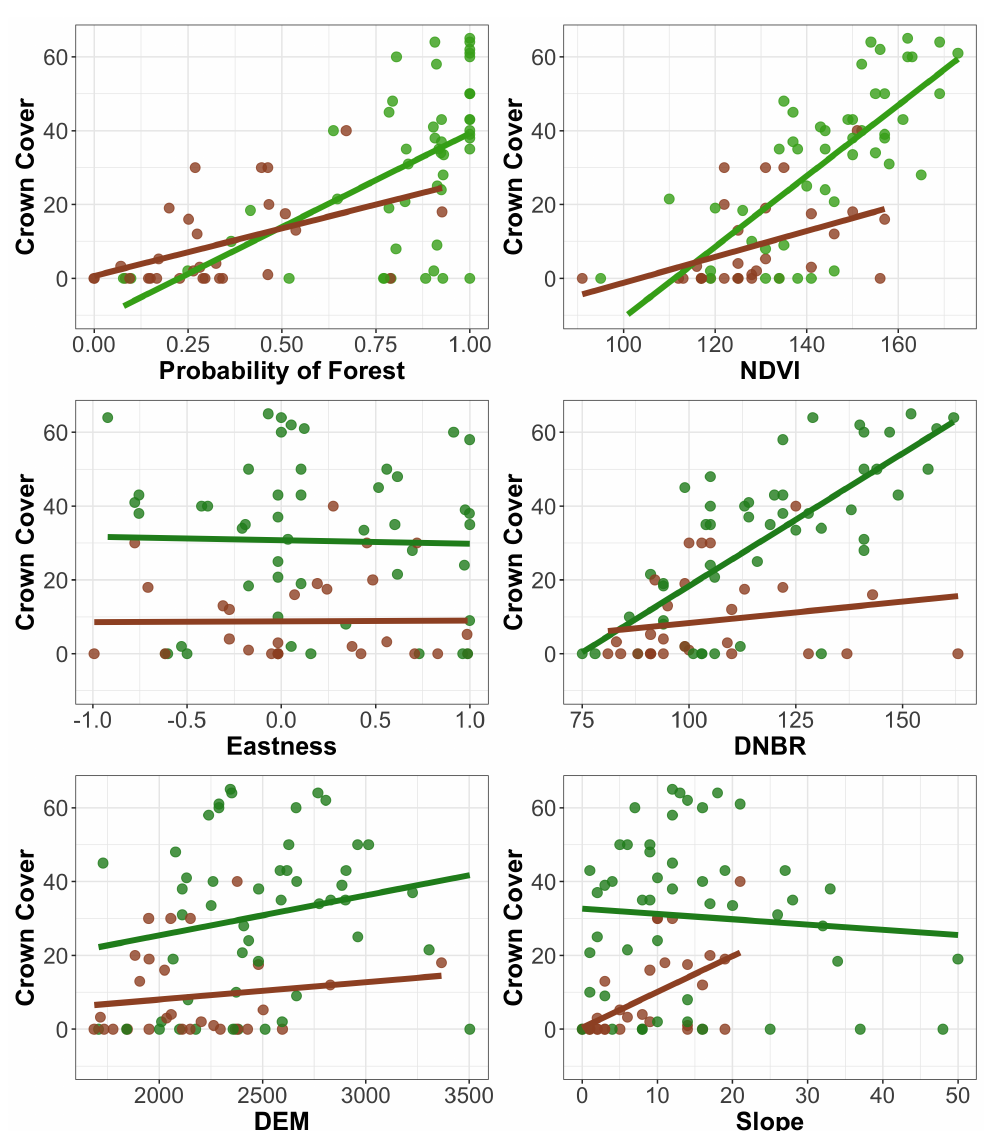
Figure 3. Crown cover graphed against the quantitative auxiliary variables with the forest-nonforest classification given by color. Green represents plots classified as forest and brown as nonforest. The least squares regression line is